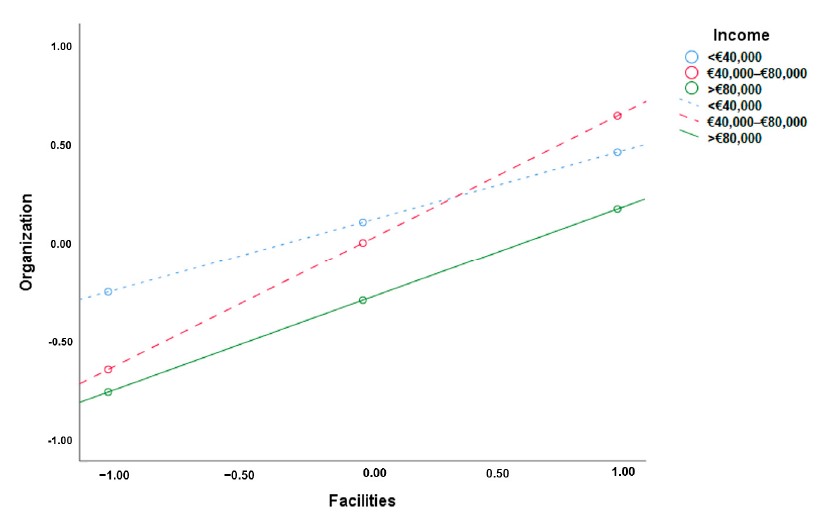
Figure 3. The moderating effect of income on the relationship between facilities and organization.